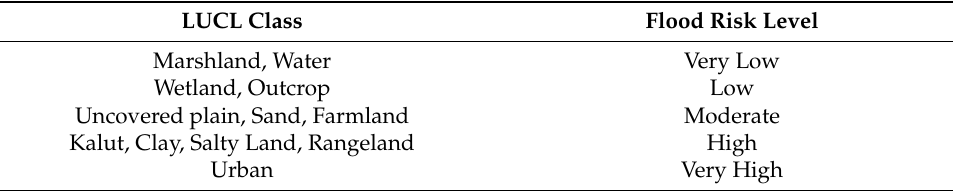
Table 3. Reclassifying the LULC map based on the level of flood